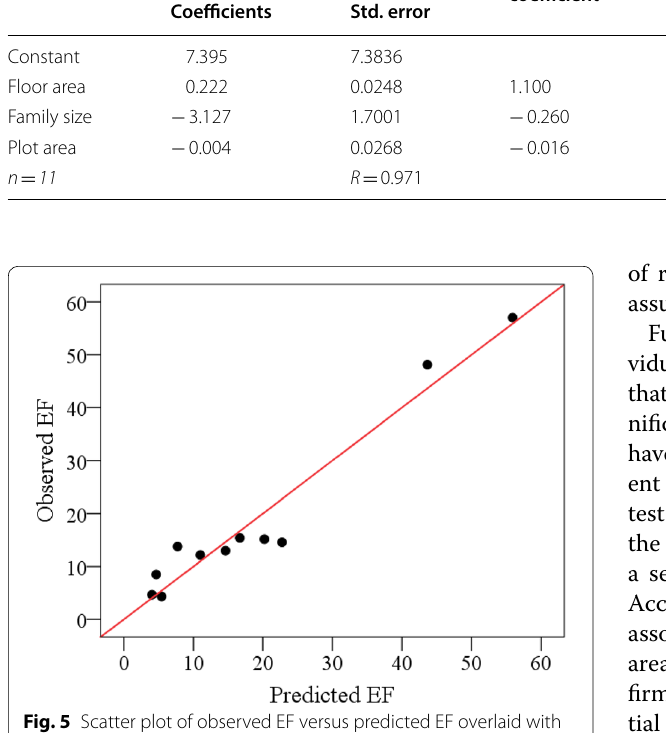
Table 3 The output of linear regression of response variable (EF) and three explanatory variables Variable